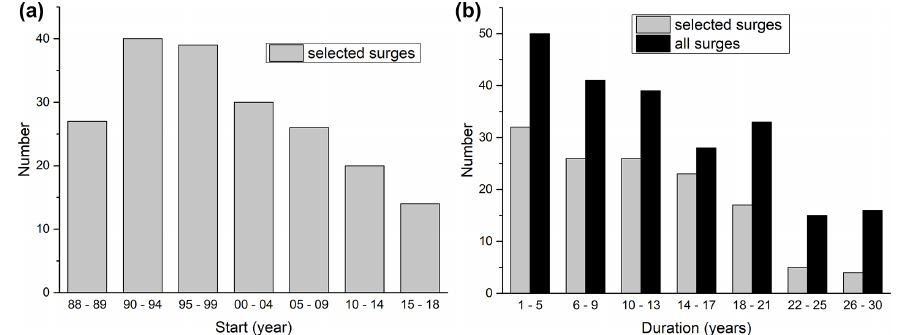
Figure 13. Histograms of surge characteristics. (a) Periods in which the surges started and (b) surge durations. The charts provide greater detail than the classification code to allow for a better analysis and keep the glacier code in the inventory simple. The “88–89” label in (a) includes only glaciers that started surging in 1989 as we cannot be sure about a surge start in 1988 (it might also have been earlier). The grey bars in (b) refer to the surges that occurred completely within the study period, i.e. starting after 1988 and ending before